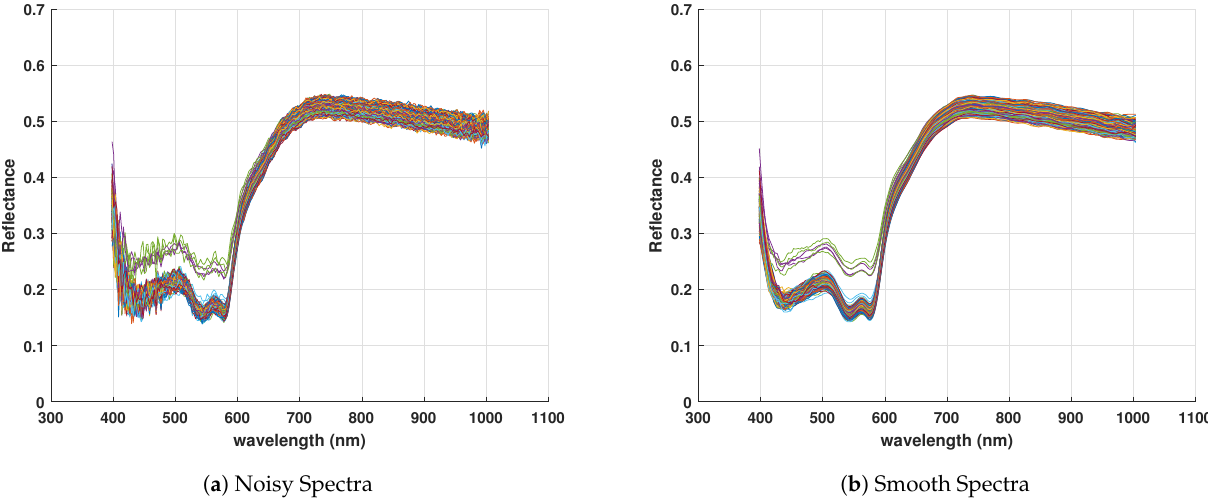
Figure 3. Spectral signature of few pixels: ( a ) Reflectance spectra with noise. ( b ) Reflectance spectra after